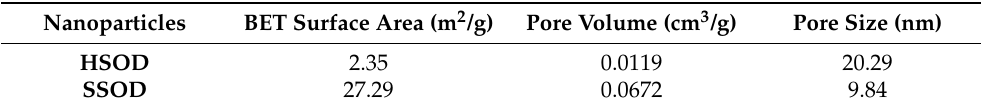
Table 1. BET analysis of HSOD synthesized via the hydrothermal method and SSOD synthesized via topotactic conversion.